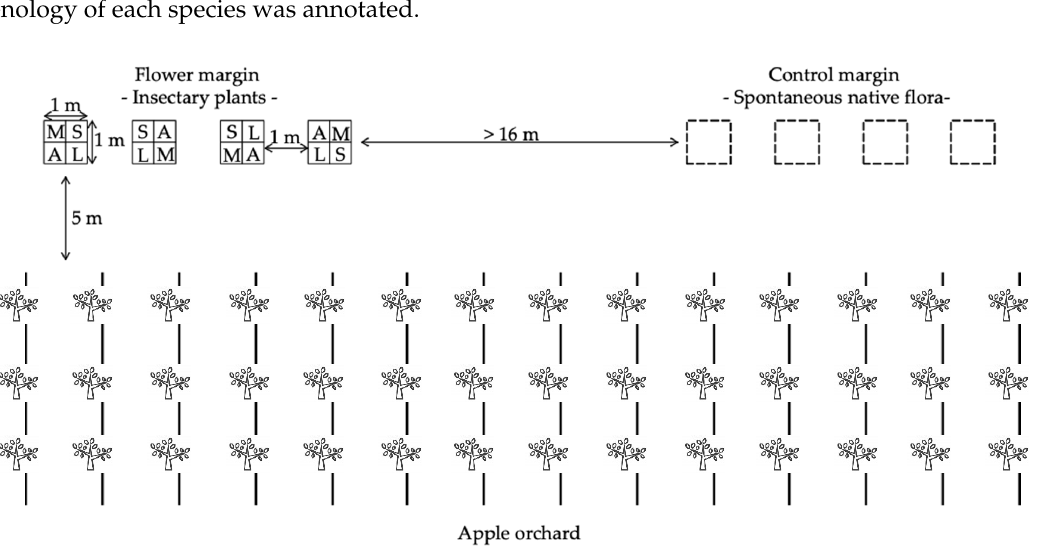
Figure 1. Setup of the experiment. A= A. millefolium , L= L. maritima , M= M. arvensis , S= S. alba